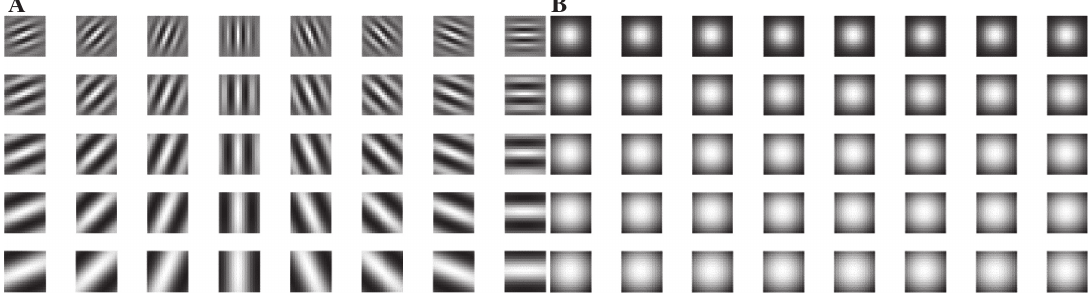
Figure 8: Gabor Wavelet Filter Bank: (A) Real Parts, (B)